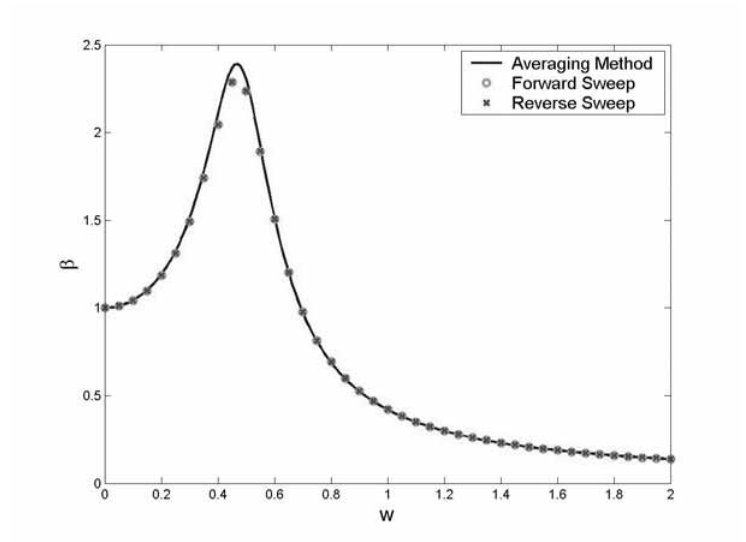
Fig. 8. Absolute engine mass displacement.